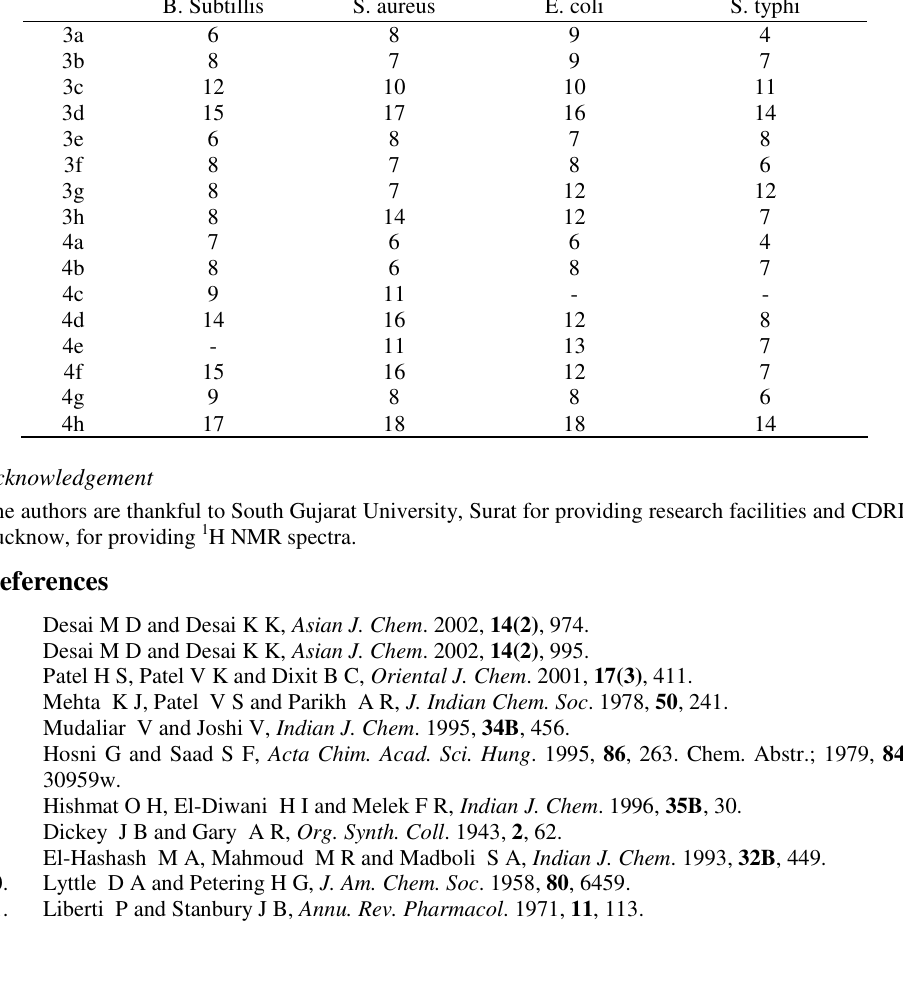
Table-3 Antibacterial Activity of Newly Synthesized Compounds, Zone of Inhibition (mm). Gram positive Gram negative